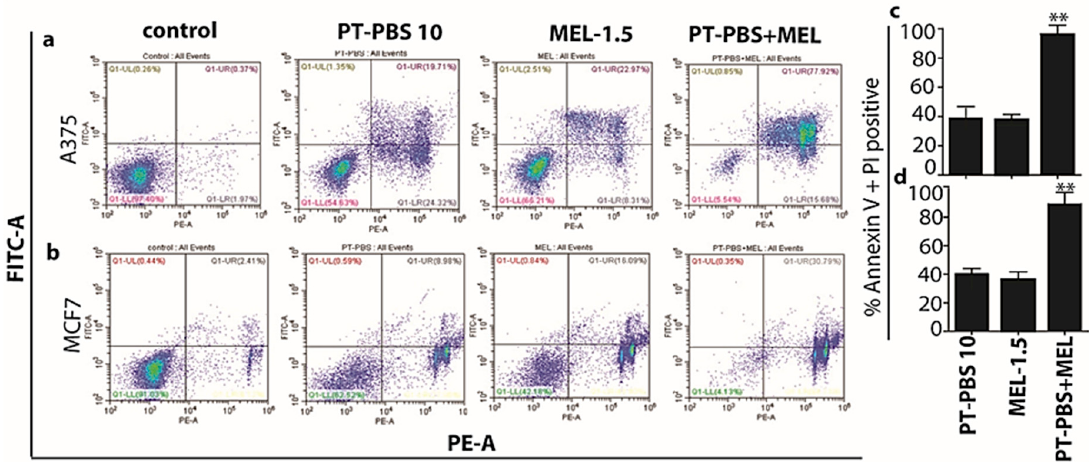
Figure 5. Flow cytometry analysis of the ( a ) A375 and ( b ) MCF7 untreated control cells, or treated with PT-PBS 10, MEL-1.5, and combined treatment (PT-PBS 10 and MEL-1.5). Percentage of cell death in ( c ) A375 and ( d ) MCF7 upon treatment with PT-PBS 10, MEL-1.5 and in combination. All values are expressed as mean ± SD; ** = p ≤ 0.01.